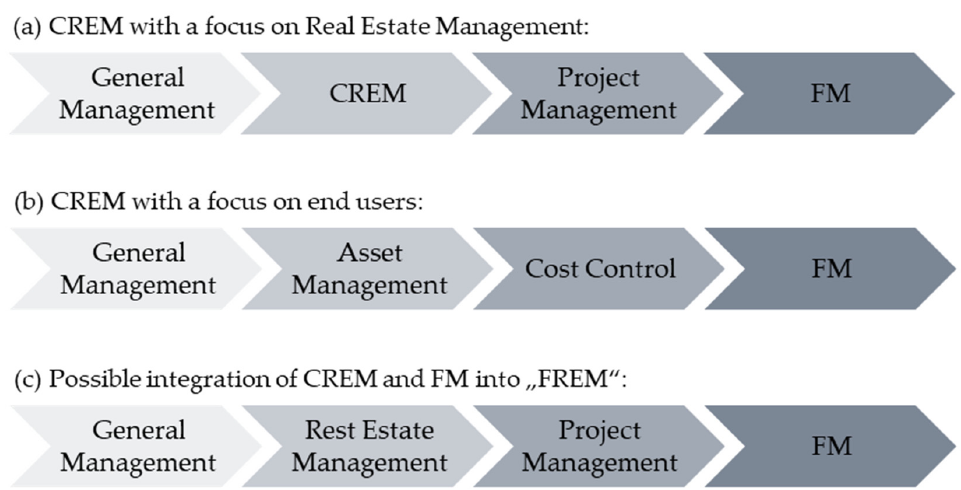
Figure 3. ( a ) CREM with a focus on real estate management; ( b ) CREM with a focus on end users; ( c ) Possible integration of FM and CREM into FREM (according to van der Voordt